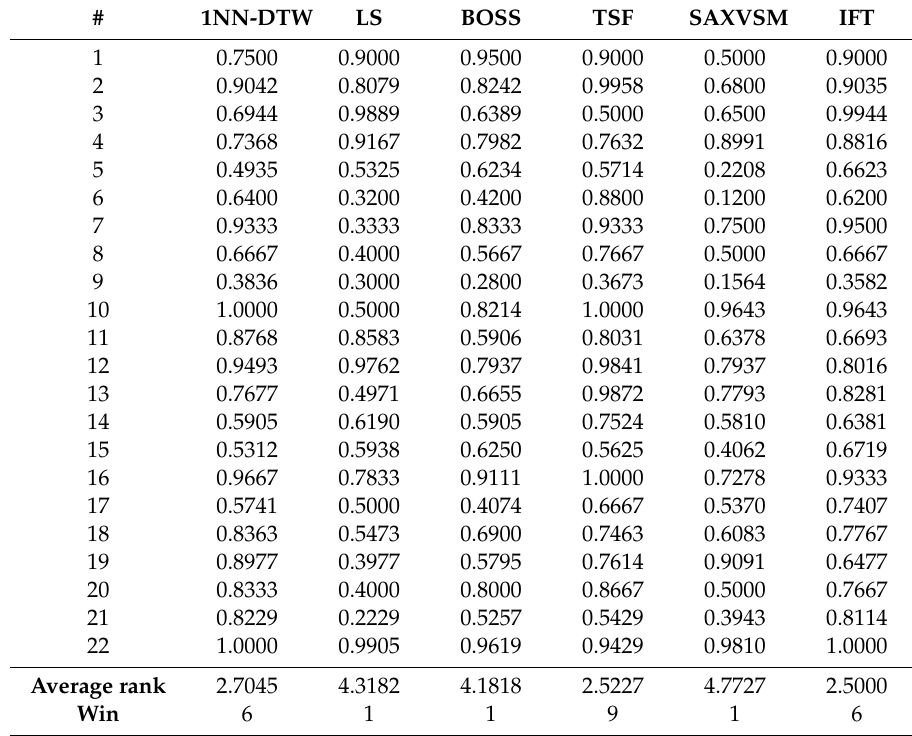
Table 3. Classification performance as represented by accuracy values of the IFT classifier compared to 1NN-DTW and several feature-based methods over multiple time series data sets. LS: Learning Time-Series Shapelets; BOSS: Bag-of-SFA Symbols; TSF: Time Series Forest; SAXVSM: Symbolic Aggregate approXimation and Vector Space